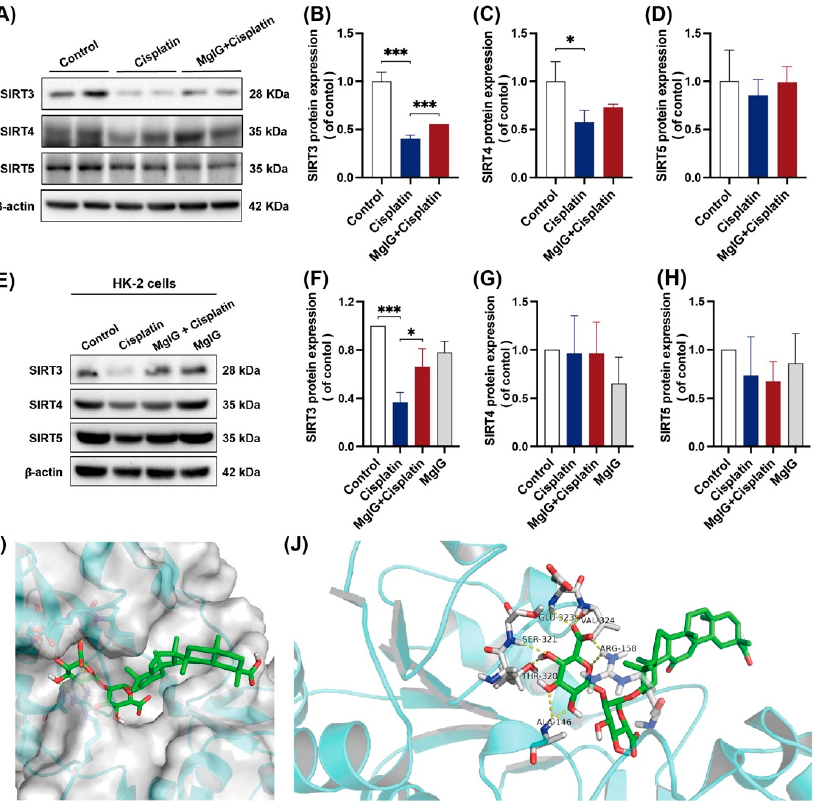
Figure 5. MgIG can bind to SIRT3 and prevent the decreased expression of SIRT3 induced by cisplatin. ( A – D ) Representative images and quantitative results of Western blot showing SIRT3, SIRT4, and SIRT5 expression in kidneys from the indicated groups, n = 3. ( E – H ) Representative images and quantitative results of Western blot showing SIRT3, SIRT4, and SIRT5 expression in HK-2 cells, n = 3. After co-treatment with MgIG, the SIRT3 level in both HK-2 cells and kidneys was upregulated. ( I , J ) Molecular docking results showing the possible sites of MgIG acting with SIRT3. MgIG could form hydrogen bonds with ALA at 146, ARG at 158, THR at 320, SER at 321, GLU at 323, and VAL at 324 of SIRT3, and π – π interaction with ARG at 158. The data are presented as the mean ± SD, n = 3. * p < 0.05, *** p <